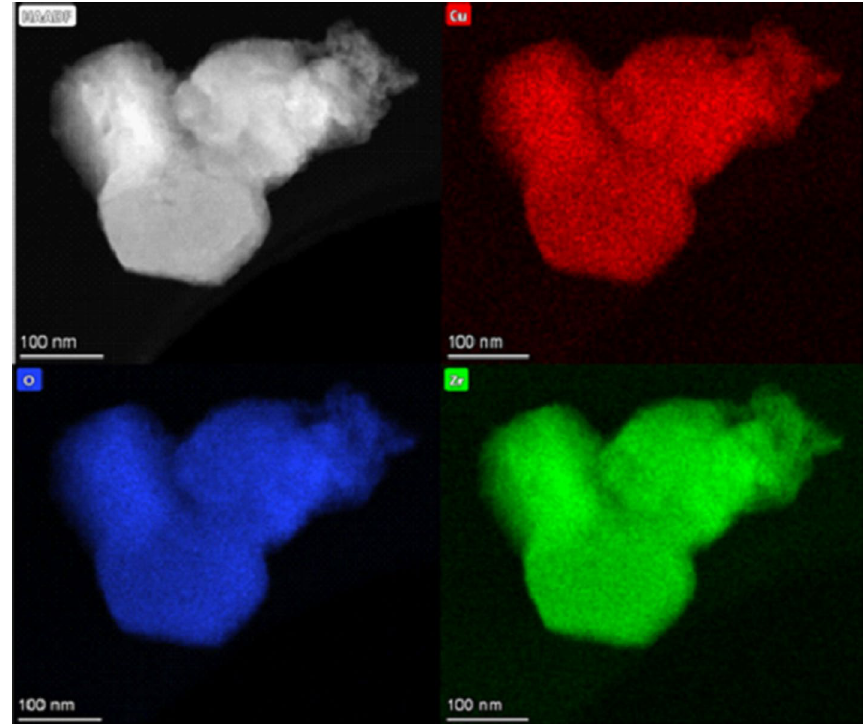
Figure 1. TEM images taken on Cu@EHU-30 showing the elemental distribution determined by